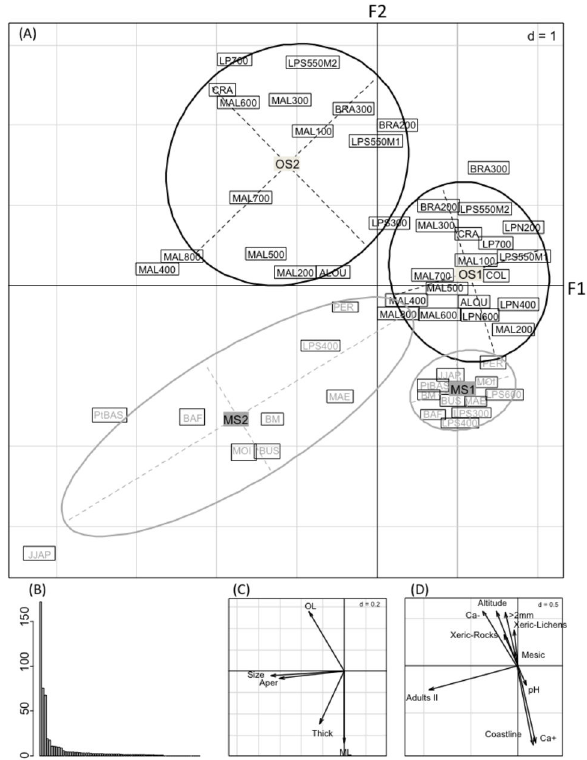
Figure 4. Redundancy analysis (RDA) of shell parameters matched with environmental variables in adult Notodiscus hookeri . Panel A shows the plot of the first two components axes of the RDA where the position of the sites is the gravity center of the sample (n=8 adult snails). The 95% confidence ellipses on the main graph illustrate a clear-cut separation of two ecophenotypes per adult age with a mineralised-shell (MS1 for adult-1, MS2 for adult-2) or an organic-shell (OS1, OS2). Panel B shows the distances between the individuals and the largest distances between the nodes were used to separate the clusters (panel A). No adult-2 snails were collected at the sites LPN 200, LPN 400, LPN 600, LPS600 and COL, therefore the number of snails analysed was n = 220. For abbreviations, see the Figure 1. Panel C is the projection of the response table (shell parameters) correlations with the RDA axes. Panel D is the projection of the environmental variables correlations with the RDA axes. Abbreviations of the shell parameters are: shell size (Size) and shell thickness (Thick), shell aperture diameter (Aper), thicknesses of the organic layer (OL) and the mineral layer (ML). Abbreviations of the sites along altitudinal gradients are: Malpassée (MAL from 100 to 800 m), Labourage-Pâturage (LP North (N) and South (S), from 200 to 600 m, two habitats (M1, M2 at LPS550 m), LP culminates at Mont 700 (LP700). Refer to Figure 1 for other abbreviations; Abbreviations of the soil types are: exchangeable calcium in clay (Ca+), soil deprived of clay and calcium (Ca-); Habitat typology is referred to as Coastline, Mesic, Xeric-rocks and Xeric-lichens; the fraction of particles > 2 mm in the soils is abbreviated: >2